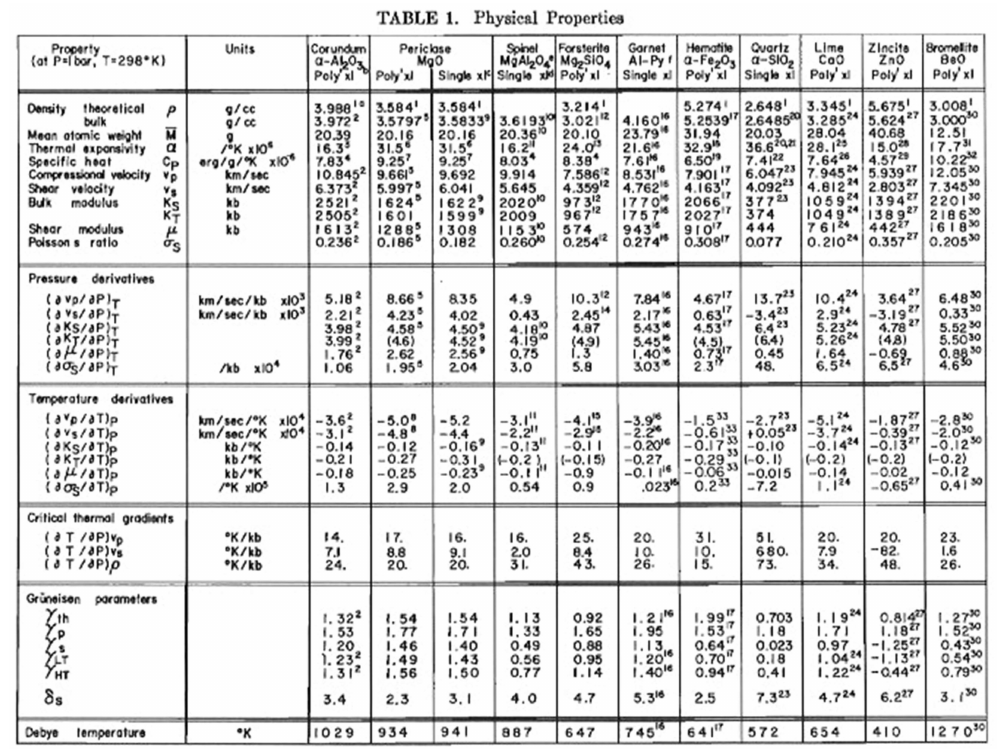
Figure 3. Summary of elastic properties of minerals from Anderson, Schreiber, Liebermann, and Soga